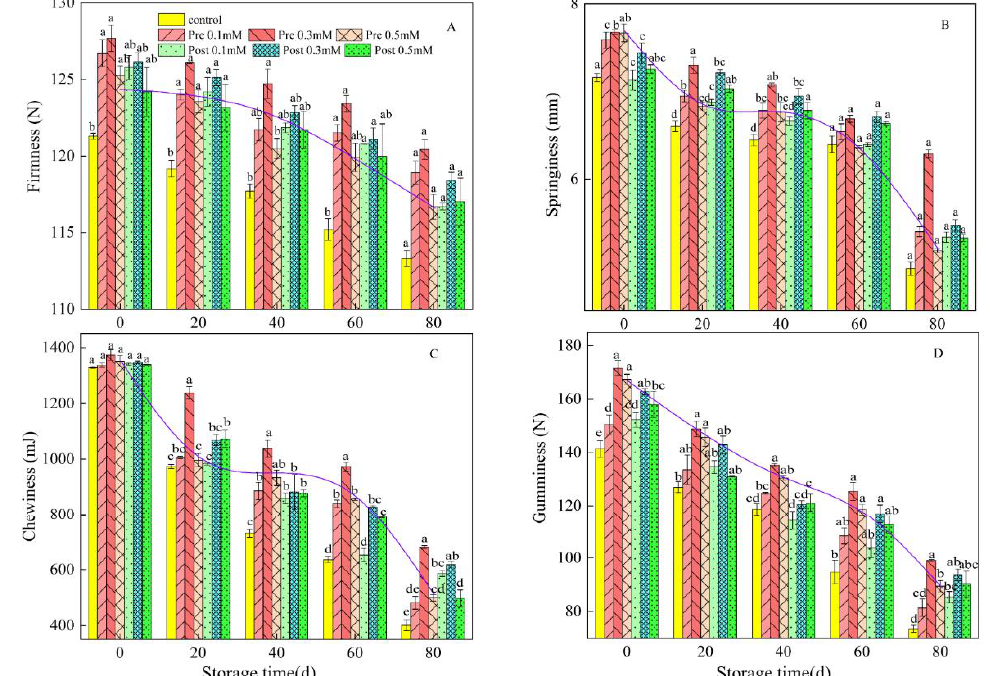
Figure 3. Effect of pre-harvest (Pre) and post-harvest (Post) methyl jasmonate treatments on firmness (A), springiness (B), gumminess (C), and chewiness (D) of lemons in storage at 7 °C – 10 °C. Data are the mean ± SE of three replicates of five fruit. Different lowercase letters show significant differences among treatments for each sampling date at p < 0.05 level.